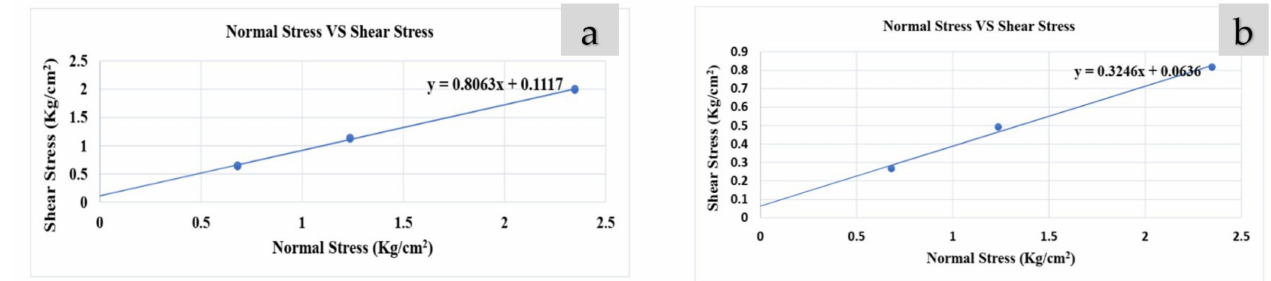
Figure 5. Shear strength envelop ( a ) 0 to 5 ft ( b ) 6 to 10